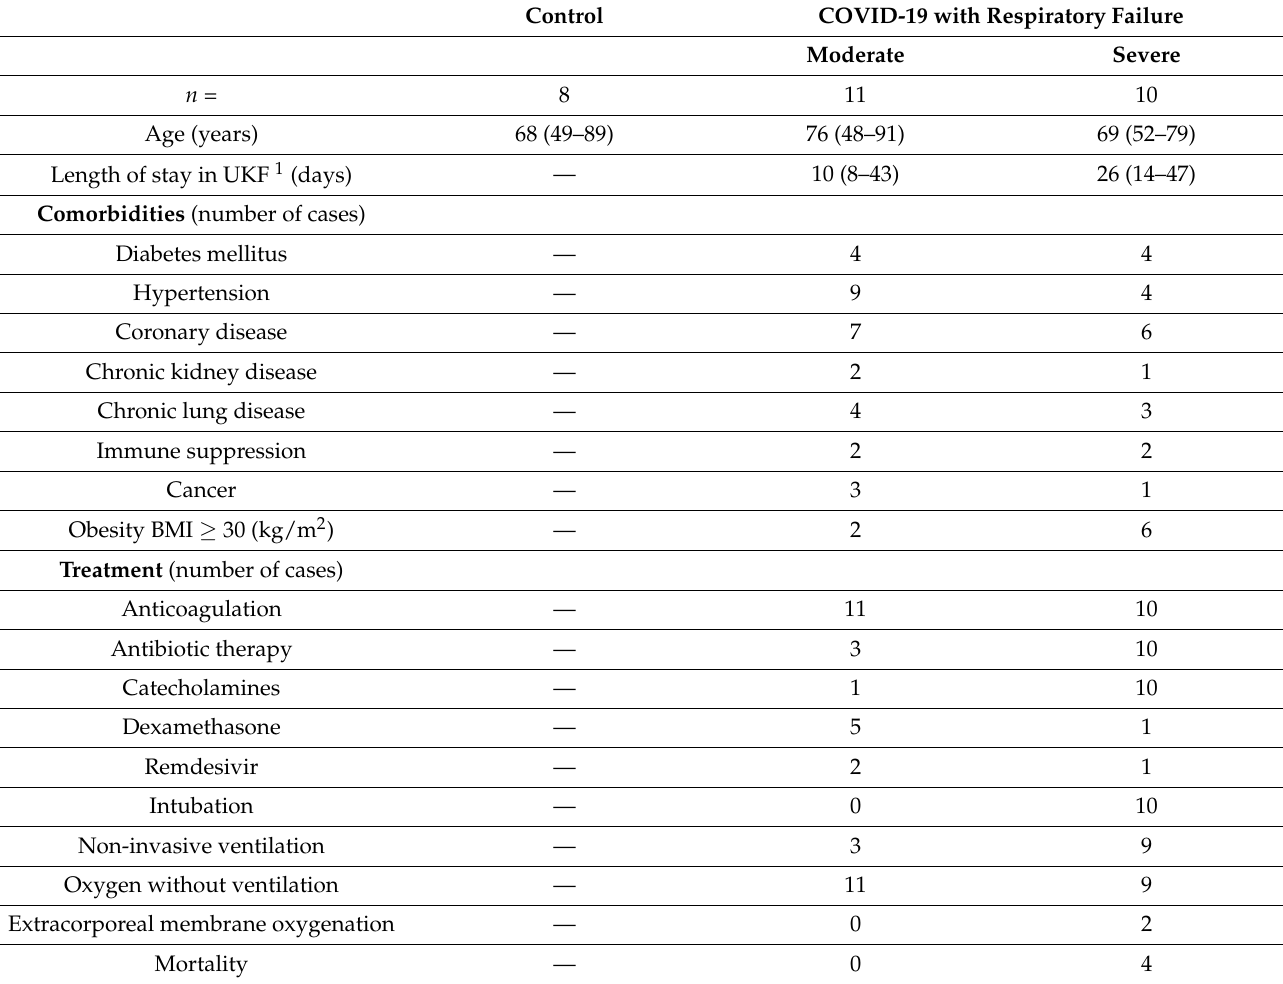
Table 1. Patient